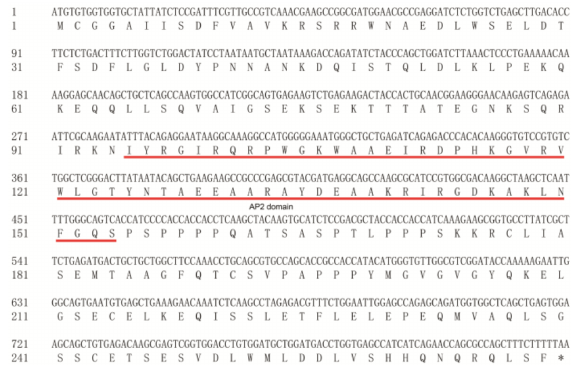
Figure 1. The conserved APETALA2 (AP2) DNA binding domain in the ERF72 protein. Conserved AP2 domain is indicated by underline. The stop code marks as *.